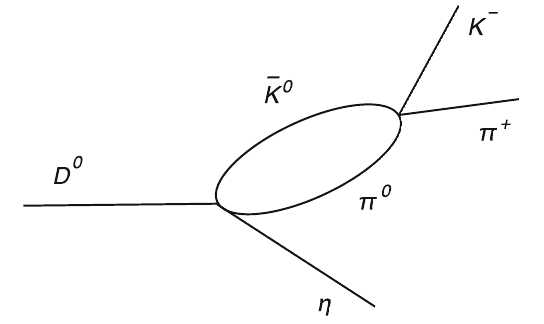
Fig. 5 Final state interaction of the ¯ K 0 π 0 pair in the ¯ K 0 π 0 η term